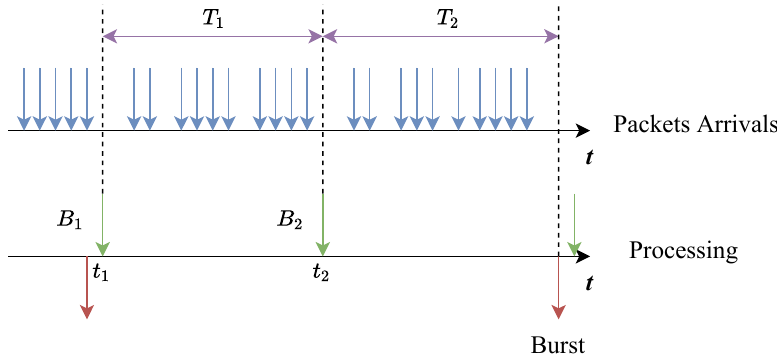
Figure 8. Schematic diagram of data plane behavior under high packet arrival